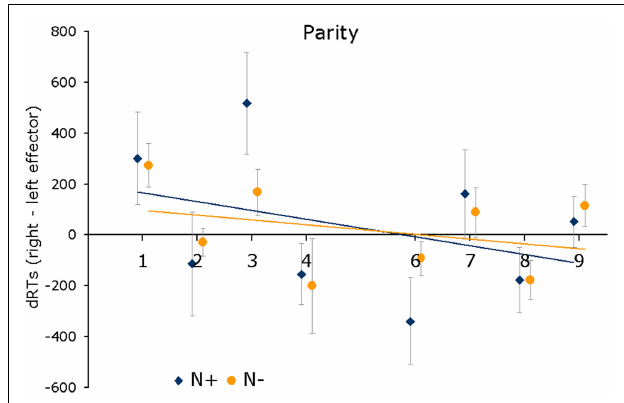
FIGURE 1 | Parity task. The mean difference in RT between right and left effector responses (dRT) to each number is plotted as a function of numerical magnitude, separately for N + and N − groups.The lines represent the regression fits for each group, computed using a continuous magnitude predictor. Error bars represent ± SEM.